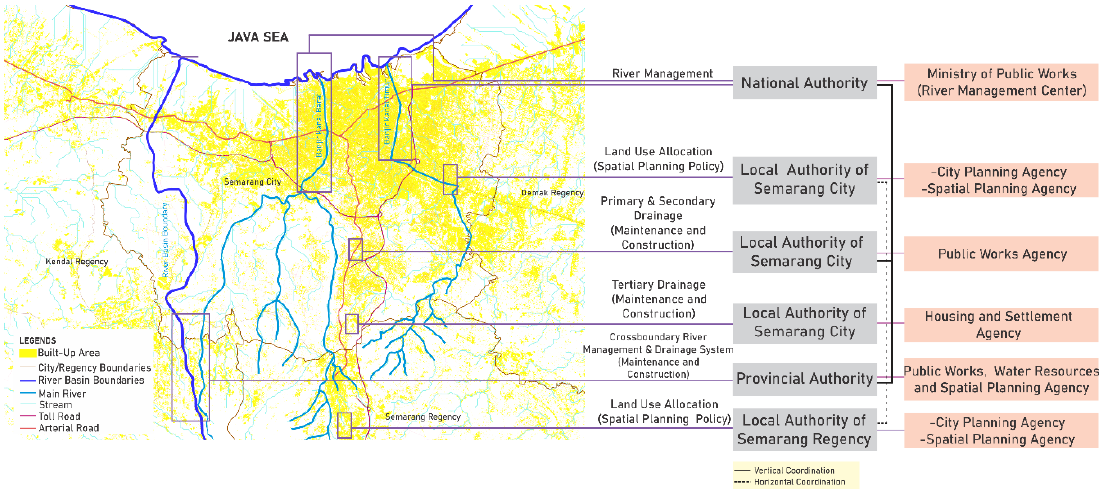
Figure 8. Roles and Responsibilities Related to River Management and Land Use Allocation.